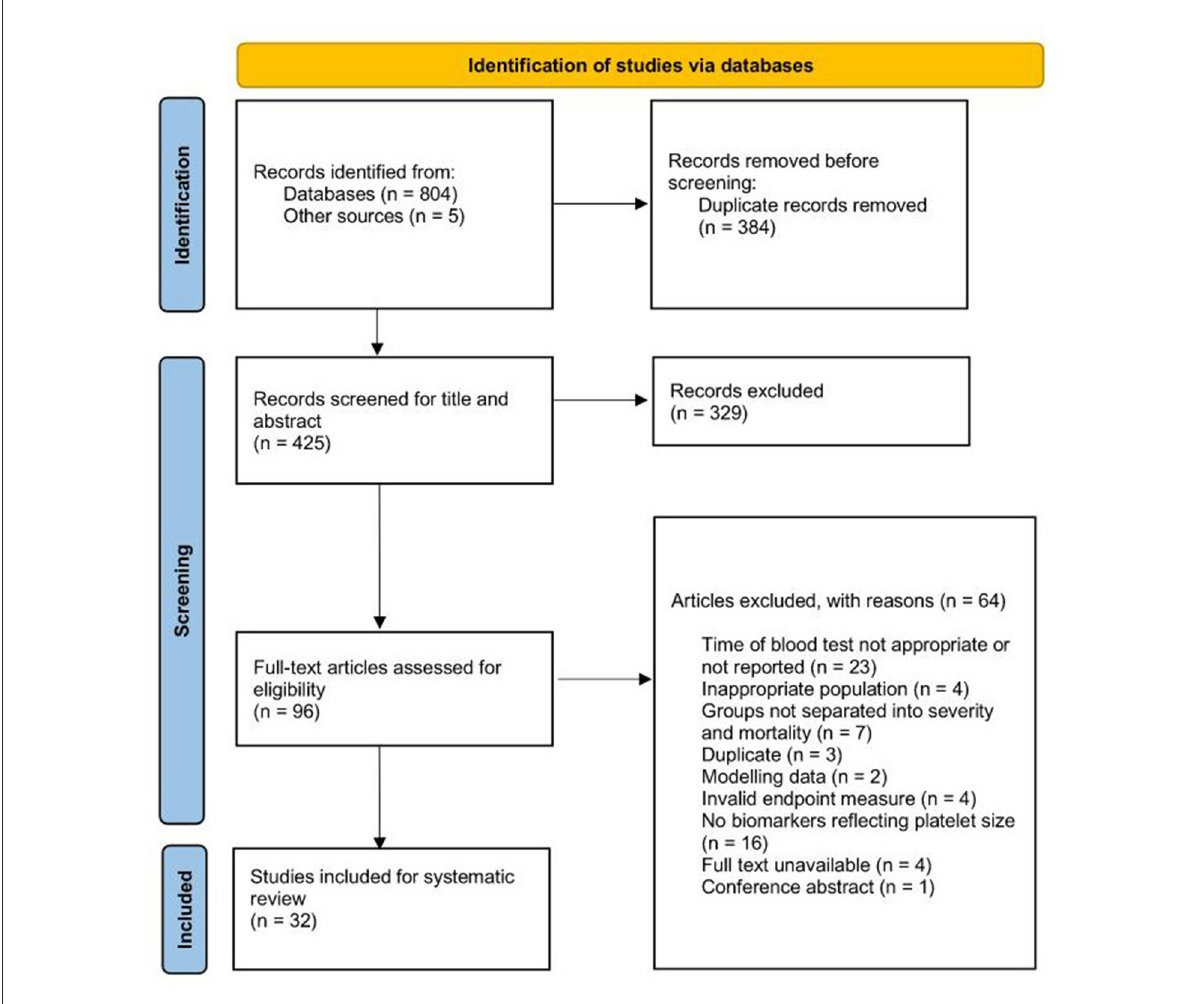
FIGURE1 PRISMA diagram of search